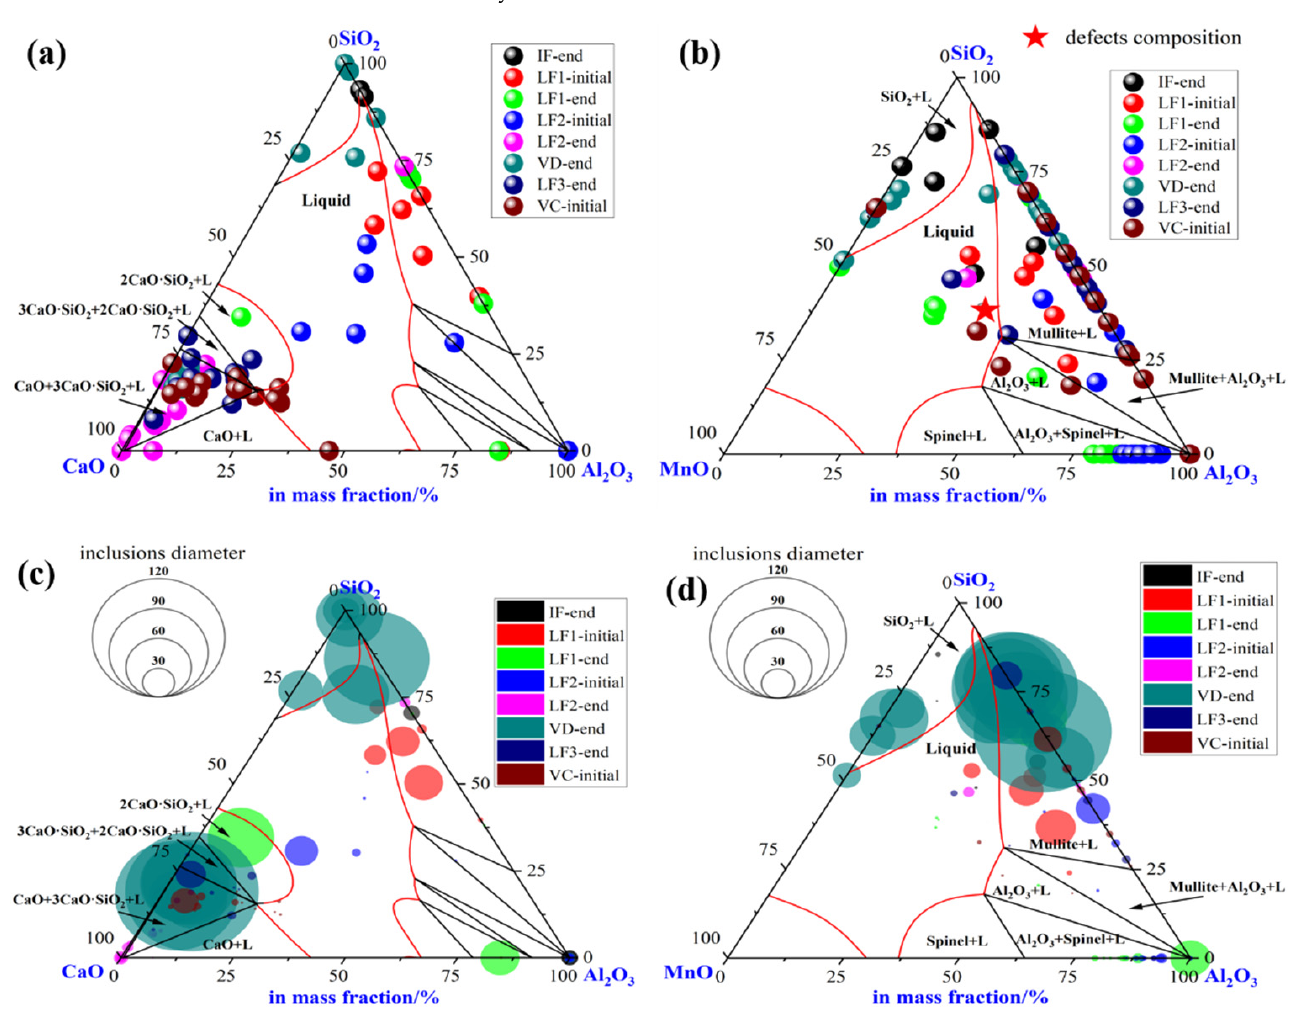
Figure 4. Composition and size distribution of inclusions during the metallurgical process in CaO-SiO 2 -Al 2 O 3 and SiO 2 -MnO-Al 2 O 3 ternary phase diagram at 1873 K. ( a ) Composition of inclusions in CaO-SiO 2 -Al 2 O 3 diagram, ( b ) composition of inclusions in SiO 2 -MnO-Al 2 O 3 diagram, ( c ) size distri- bution of inclusions in CaO-SiO 2 -Al 2 O 3 diagram, ( d ) size distribution of inclusions in SiO 2 -MnO- Al 2 O 3 diagram.